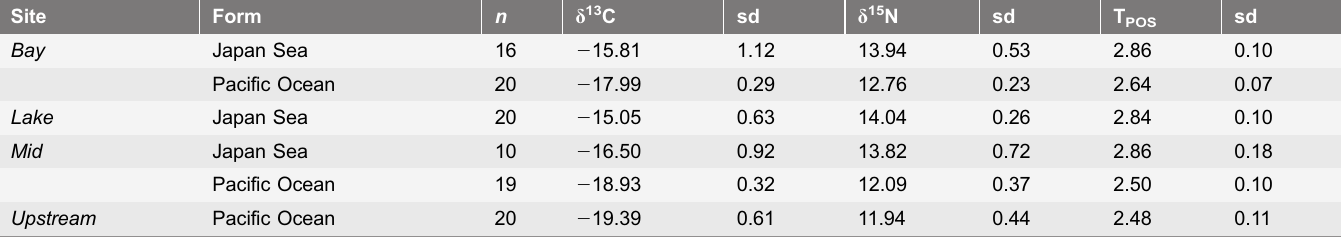
Table 1. Mean stable isotope values for sympatric Japan Sea and Pacific Ocean stickleback from Akkeshi catchment; n indicates the number of individuals used for SIA.